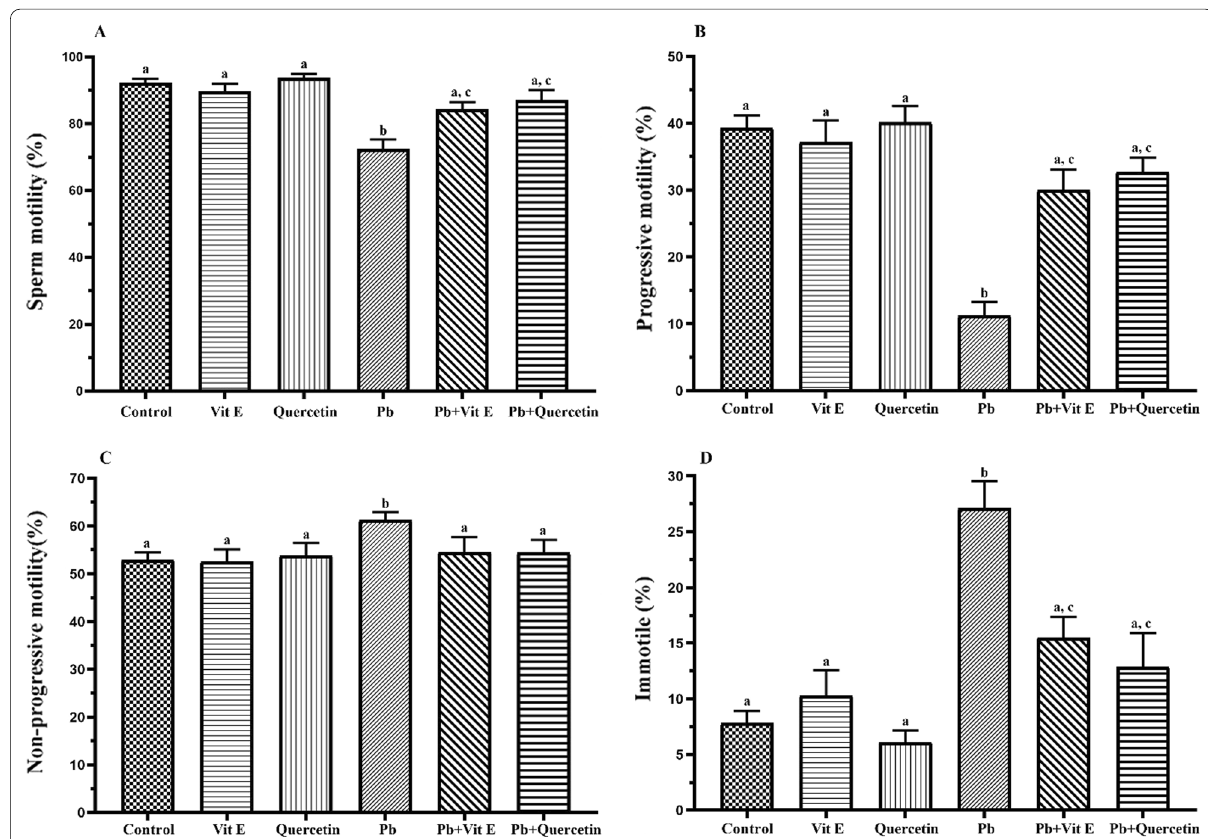
Fig. 4 Effect of Vitamin E and quercetin on sperm motility in lead acetate treated male Wistar rats. Bars represent mean different superscripts between groups differ significantly at p < 0.05